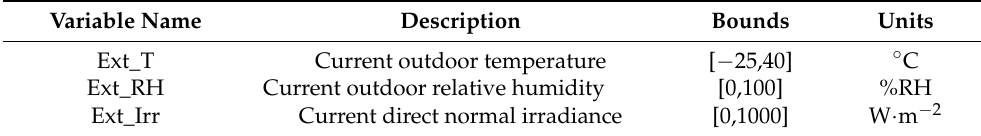
Table A1. Common outputs for the EnergyPlus based